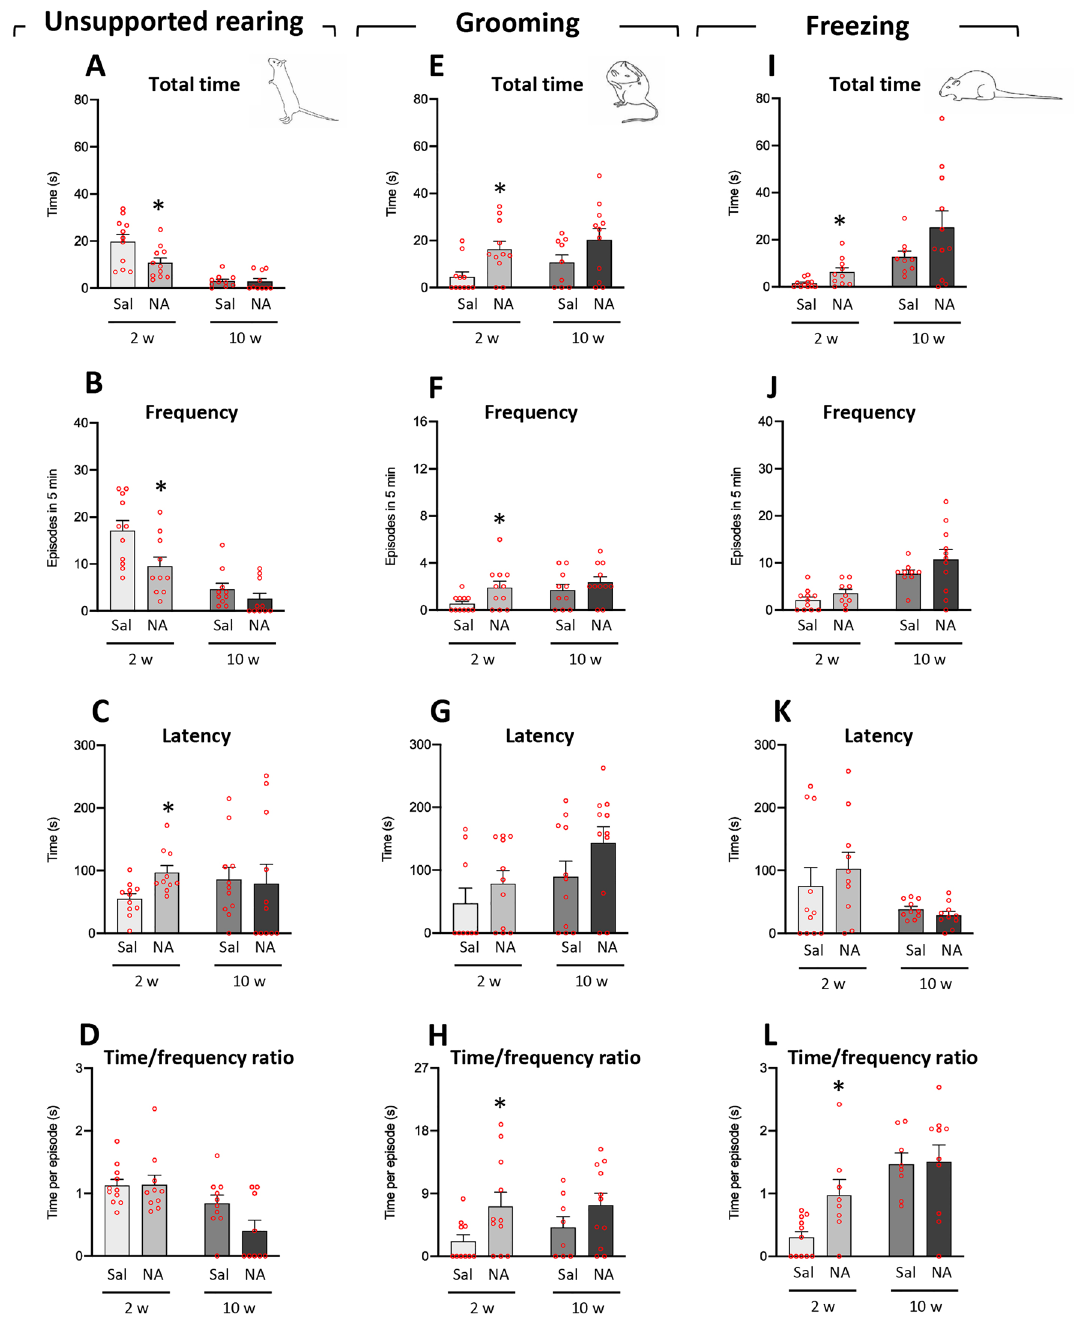
Figure 3. Parameters related to unsupported rearing, grooming, and freezing behaviors analyzed in the open field test. Rats were ICV-injected either with saline (Sal) or with neuraminidase (NA), and subjected to the open field test 2 weeks (2w) or 10 weeks (10w) after the ICV injection. Several parameters ( total time, frequency, latency of the first episode, and the time/frequency ratio ) related to the behaviors unsupported rearing ( A – D ), grooming ( E – H ) and freezing ( I – L ) were studied, and the mean values ± SEM (n = 11 for both NA and Sal) are represented in histograms. Student’s t-test were performed in order to check the influence of treatment (Sal versus NA) at both assessments. * p <